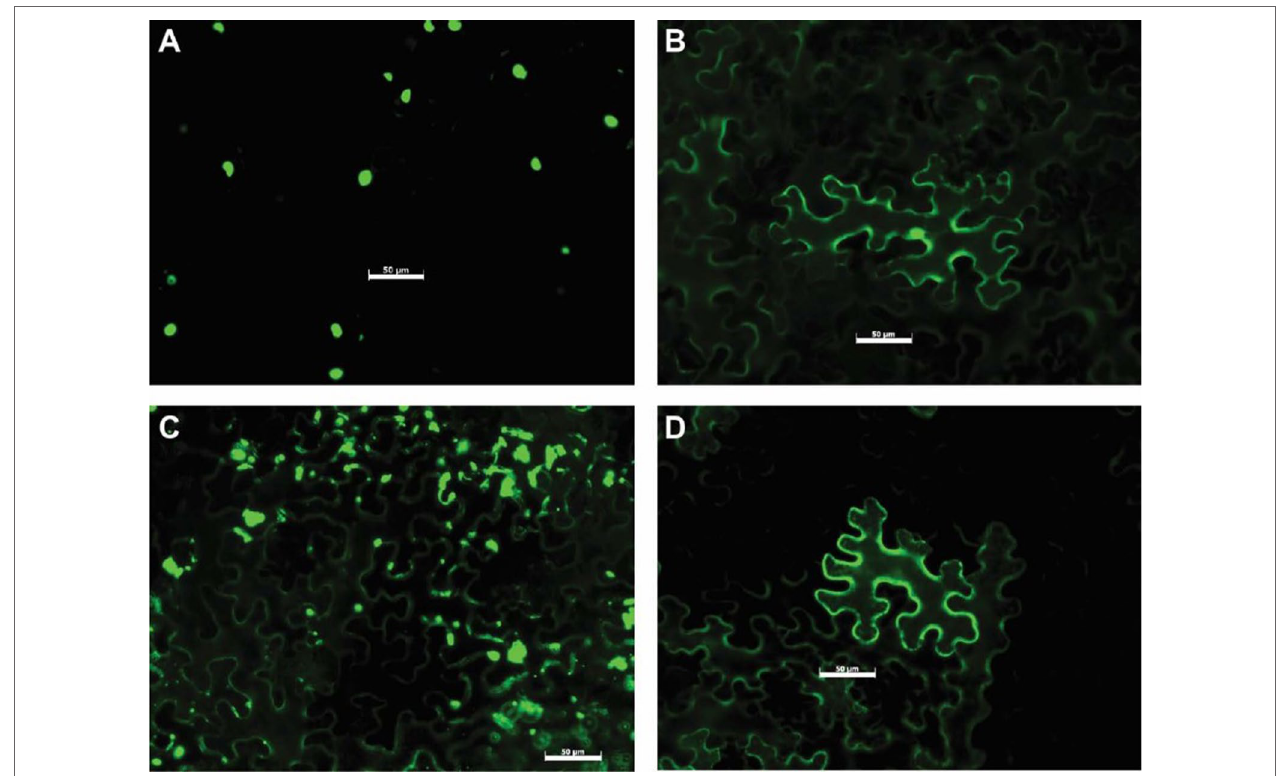
FIGURE 4 | Representative examples of Uaca_N subcellular localization. (A) Uaca_1, localized in the nucleus; (B) Uaca_2, localized in both nucleus and cytoplasm; (C) Uaca_5, localized in the cytoplasm and forming aggregates; (D) Uaca_11, localized in the cytoplasm. The scale bar is equal to 50 µm. Images were taken 48 hpi. Two replications of the imaging were performed, and at least four representative images were taken each